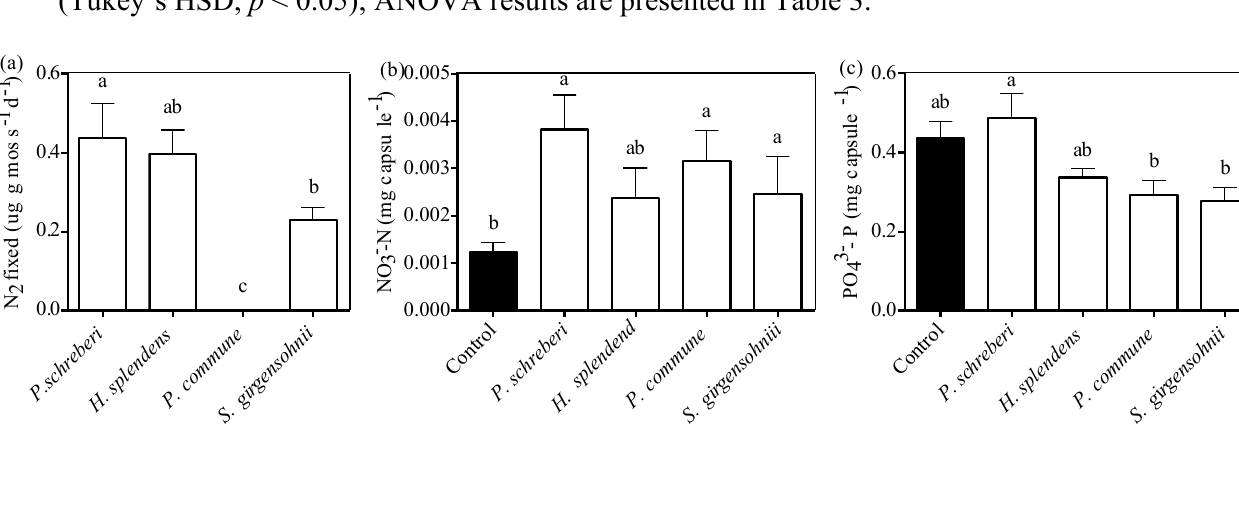
-fixation; ( b ) resin sorbed 2